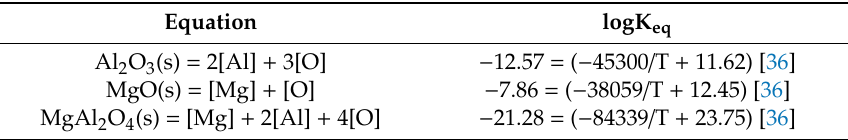
Table 5. Equilibrium constants used in this study.